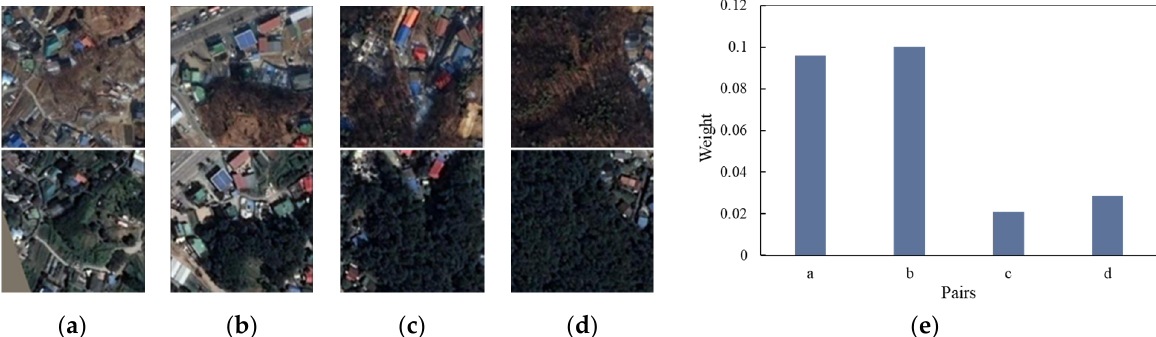
Figure 12. Examples of the weight assignment to the sub-images. ( a – d ) are the partial pairs in the same source image and target image, and ( e ) shows the comparison of the weights.